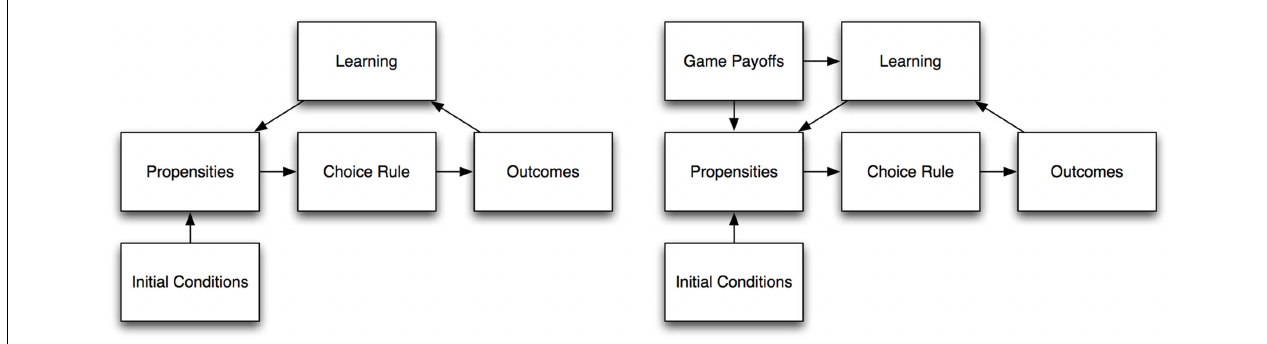
FIGURE 3 |Adapted from Marchiori andWarglien (2008): General architecture of a “propensities and stochastic choice rule” learning model (left), and general architecture of the (SOFTMAX-)PB0 model (right).